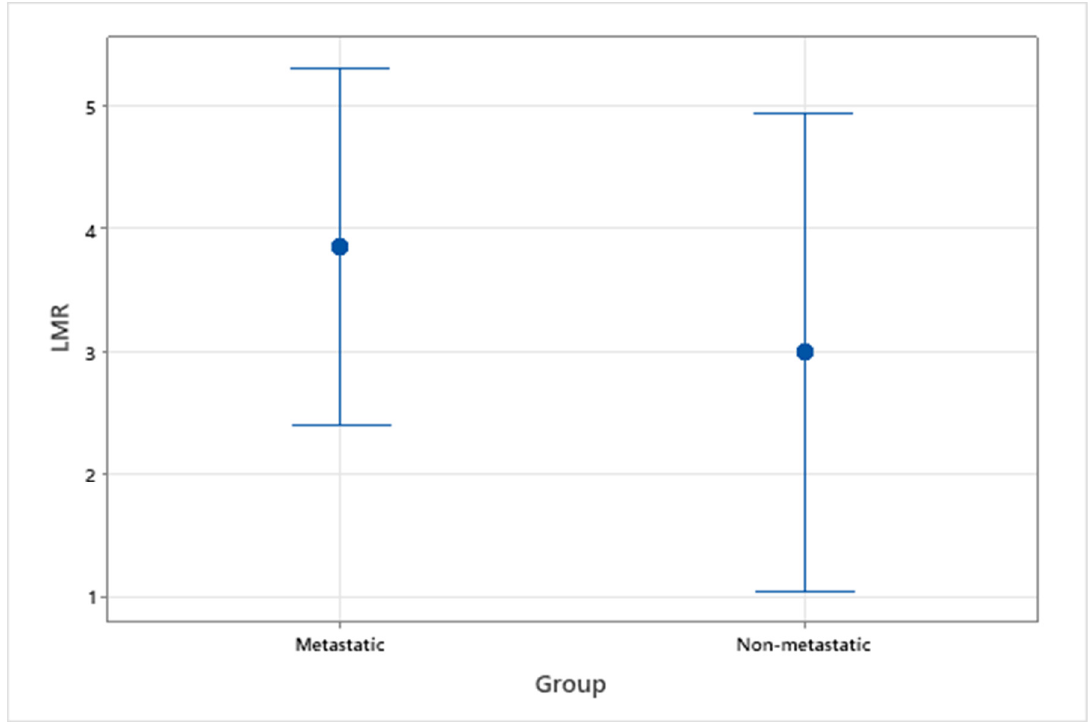
Figure 4. Interval plot of pre-treatment LMR in patients with OMM, with and without evidence of metastasis.